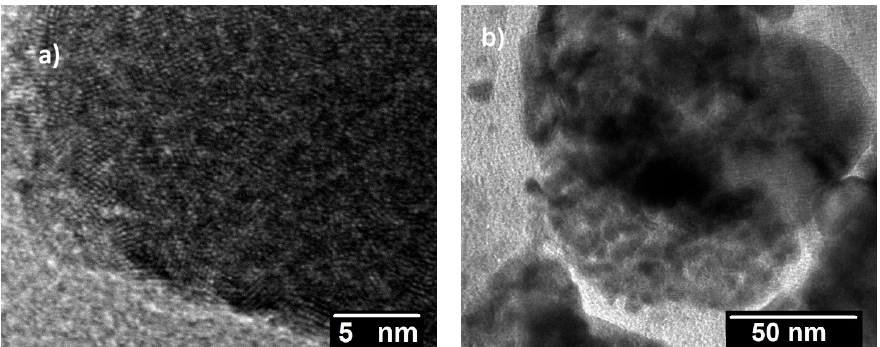
Figure 6. Bright-field TEM image with the difference in colors pointing to the presence of unreact- ed UO 2 (A) surrounded by UC 2 − y (B).